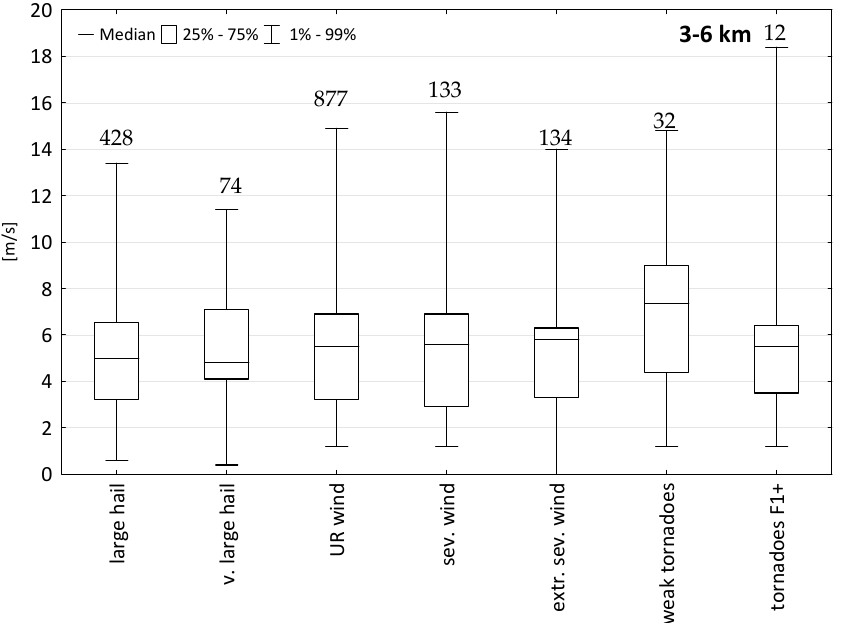
Figure 8. As in Figure 2, except for the 3–6 bulk wind shear.